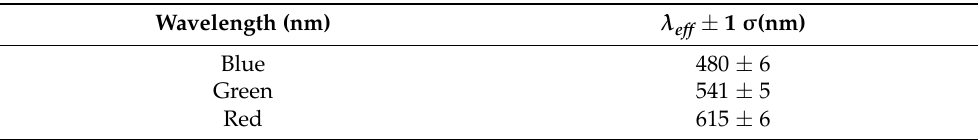
Table 2. Effective wavelengths calculated for each channel of our sky-camera. The ± 1 standard deviation is assumed as the uncertainty.